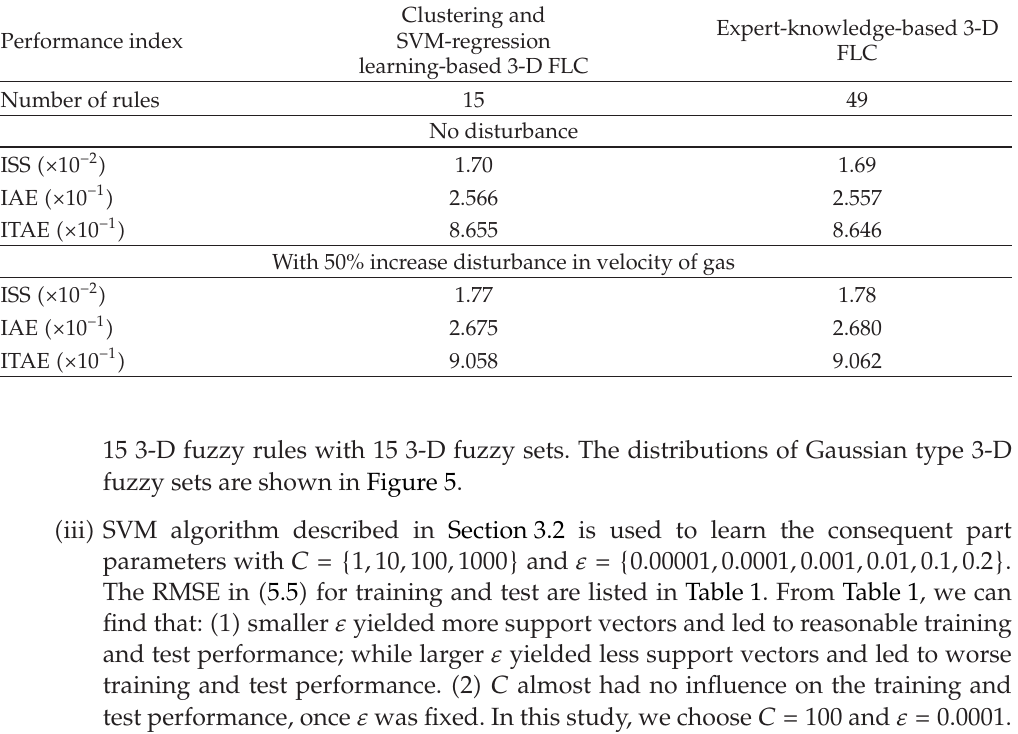
Table 2: Performance